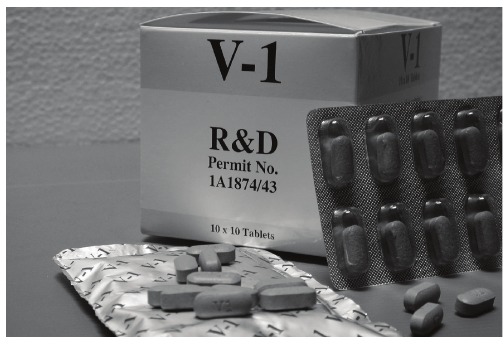
Figure 1: The appearance of V-1 Immunitor (V1) therapeutic oral AIDS